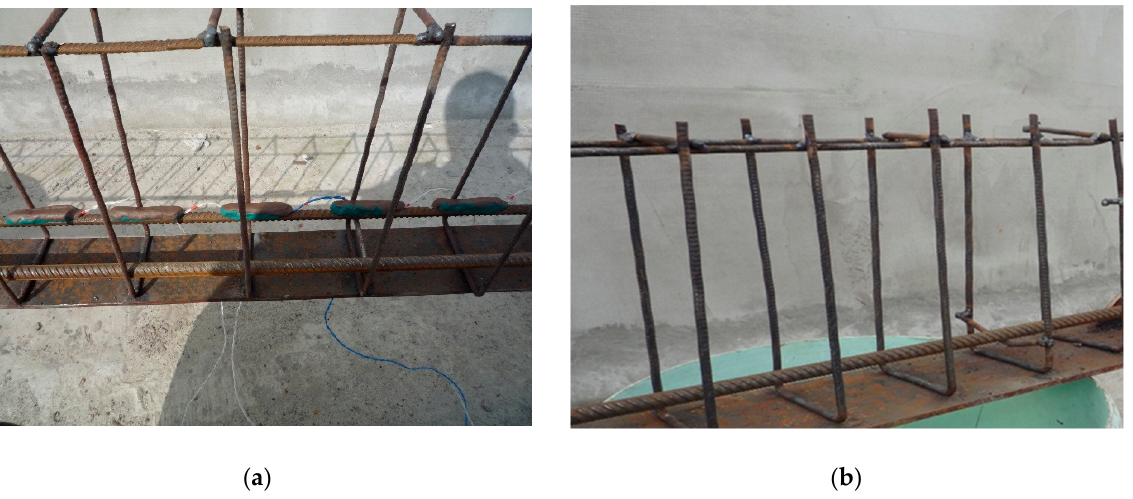
Figure 2. Frames of steel-concrete experimental beams. ( a ) Frame in the zone of pure bending; ( b ) frame in the supporting area.